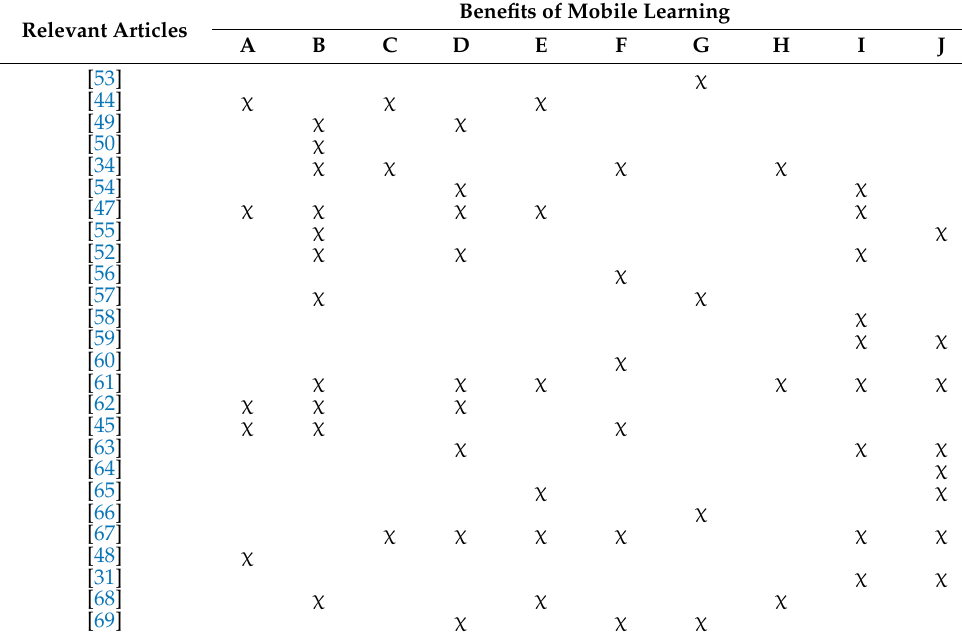
Table 4. Mobile learning benefits